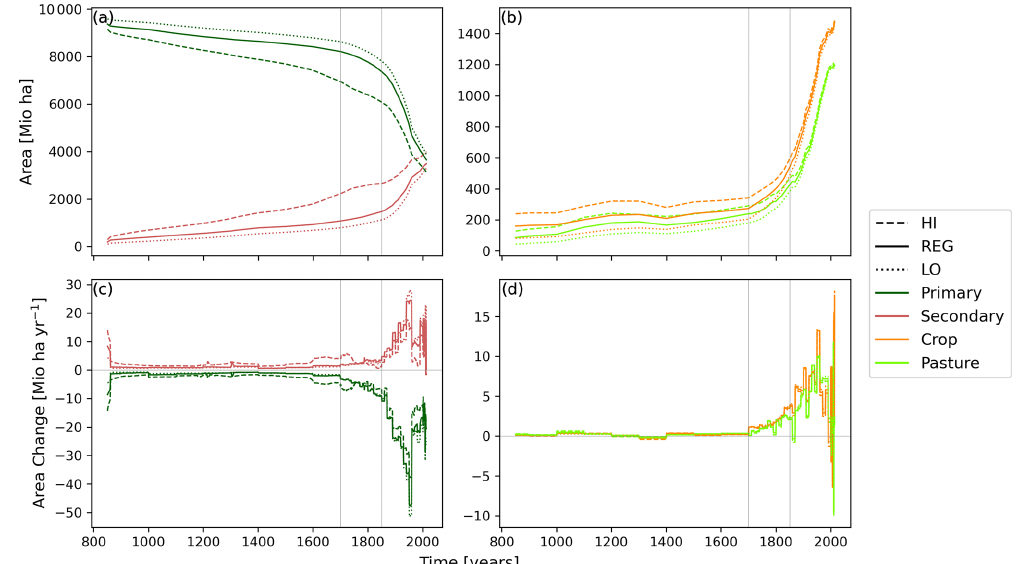
Figure A1. Global areas of the four BLUE land-cover types (primary land, secondary land, crop and pasture) based on the aggregated LUH2 input data (a, b) and their temporal net change (c, d) . Panels (a) and (c) show natural vegetation; (b) and (d) show agricultural area. Note the different y -axis ranges. HI, REG and LO correspond to the LUH2 LULCC high, baseline and low estimates, respectively.